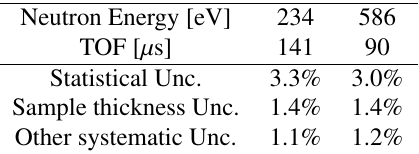
Table 1. Relative uncertainties of total cross section at two neutron